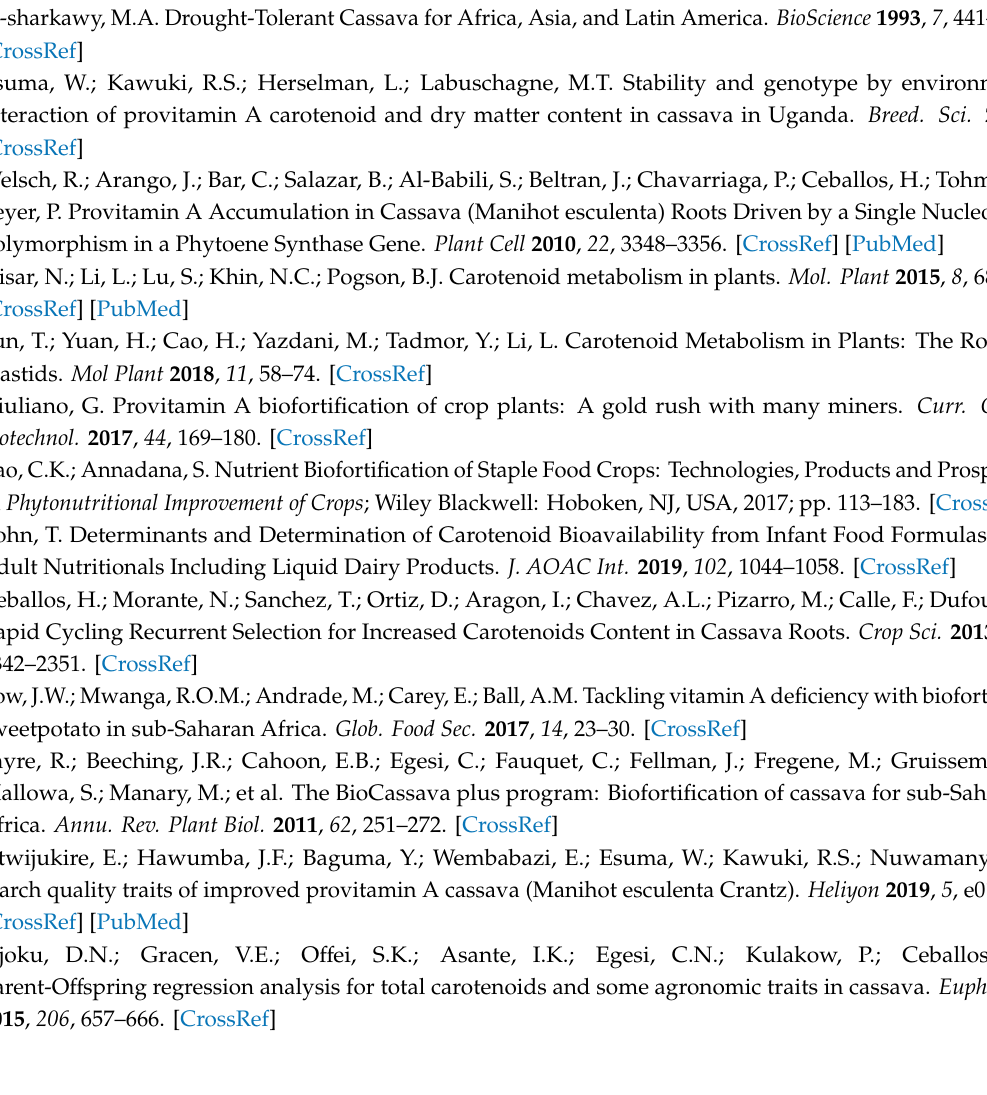
Table S1: qPCR primer sequences, Table S2: Agronomic data for average dry matter (DM) and average total carotenoid (TC) composition in storage roots at 13 months, Table S3: Relative expression determined by qPCR of carotenoid genes in six cassava genotypes, Figure S1: PCA loadings of leaf (A) and root (B)